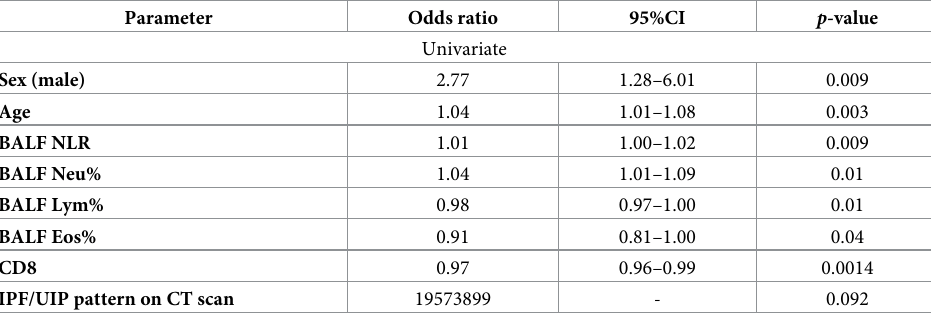
Table 2. Predictive Markers of PF-ILD according to univariate logistic regression analysis.